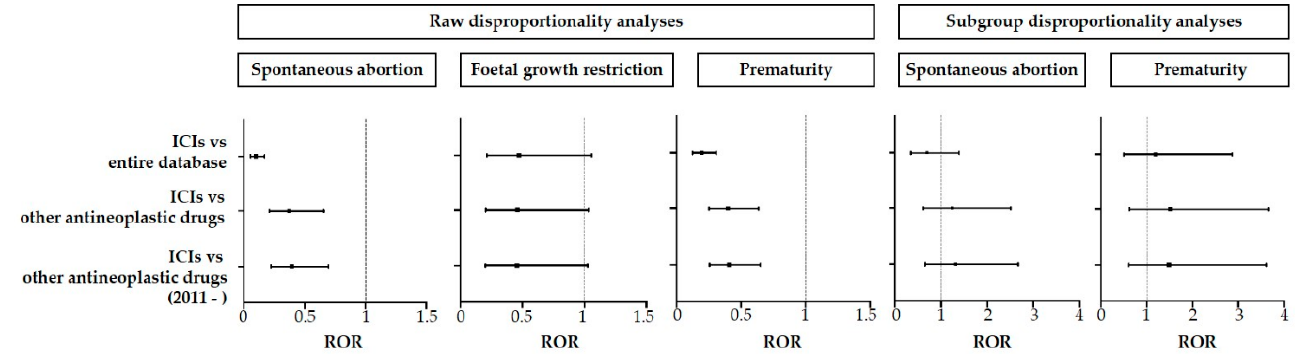
Figure 2. Raw and subgroup (by sex and age, females aged 20–44 years) disproportionality analyses between immune checkpoint inhibitors and the entire database, other antineoplastic agents, and other antineoplastic agents since 2011, to compare the reporting of spontaneous abortion, fetal growth restriction, and prematurity. Forest plots represent reporting odds ratios along with 95% confidence intervals. ICI, immune checkpoint inhibitor; ROR, reporting odds ratio; CI, confidence